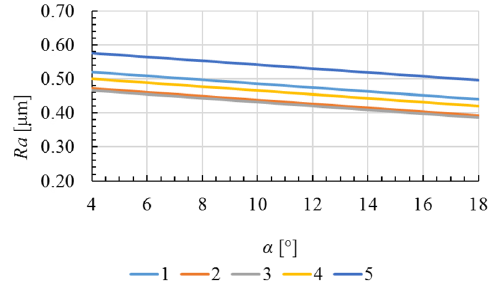
Figure 11. E ff ect of the curvature radius ρ 1 on the Ra roughness parameter in the machining of the convex surface: (1) α = 4°, (2) α = 7.5°, (3) α = 11°, (4) α = 14.5°, (5) α = 18°.